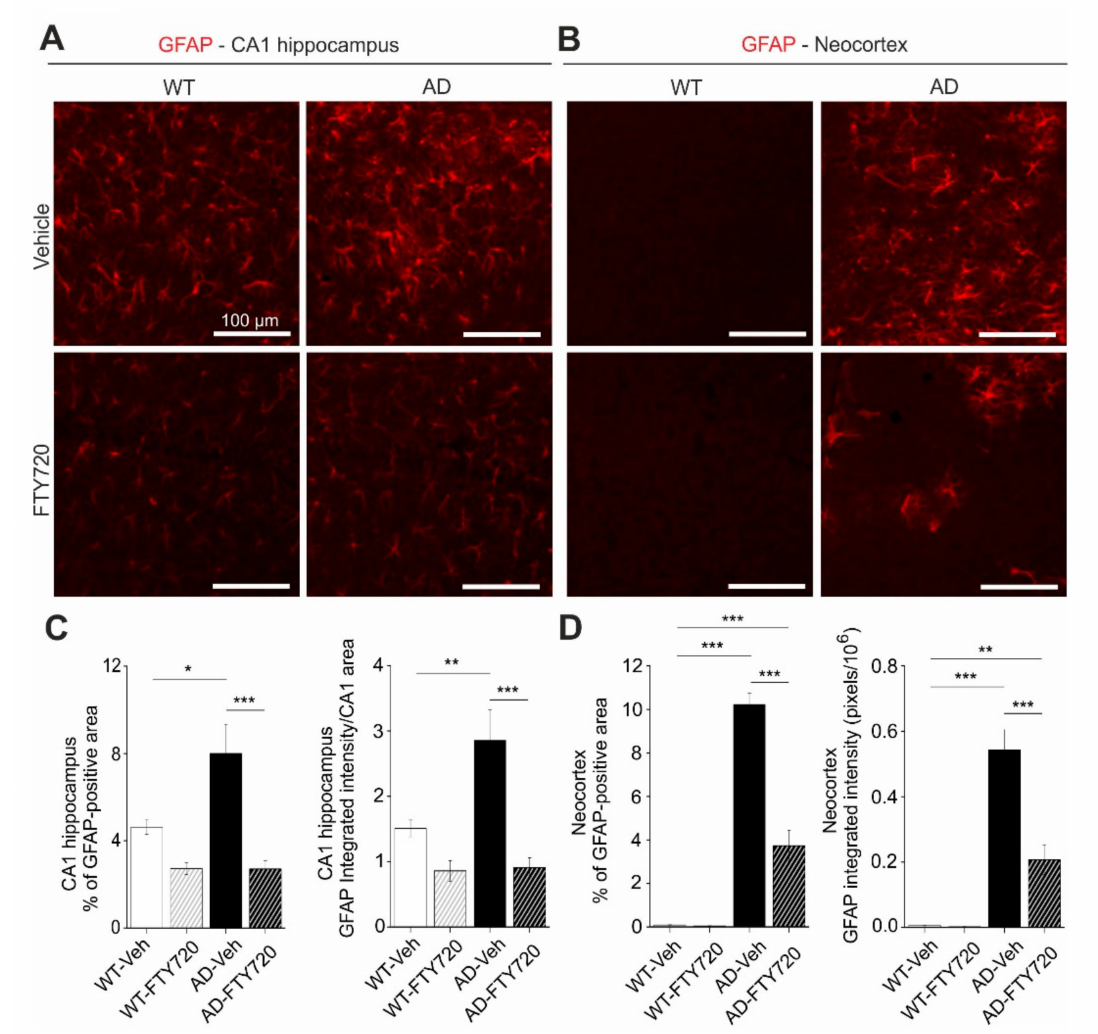
Figure5. Chronicfingolimod(FTY720)treatmentamelioratesastrogliosisinhippocampusandneocortex of APP / PS1 mice. Five- to six-month-old male WT and APP / PS1 mice were treated with i.p. injections of fingolimod for one to two months. Glial fibrillary acidic protein (GFAP) immunohistochemistry was performed in the hippocampal CA1 area ( A , C ) and in the neocortex ( B , D ) at six to seven months. ( A ) GFAP expression was detected with a red fluorescent secondary antibody. Typical examples of GFAP expression in vehicle and fingolimod treated WT (left) and APP / PS1 mice (right). ( B ) Same analysis as described for ( A ) but in the cortical sections. Illumination and exposure times as well as thresholding procedures of pictures for quantitative analysis were identical for all four groups in ( A ) and ( B ). Scale bar: 100 µ m in all images. ( C ) Quantification of the percent area of CA1 sections as shown in ( A ) that is covered by GFAP immunofluorescence ( left , representing overall area which